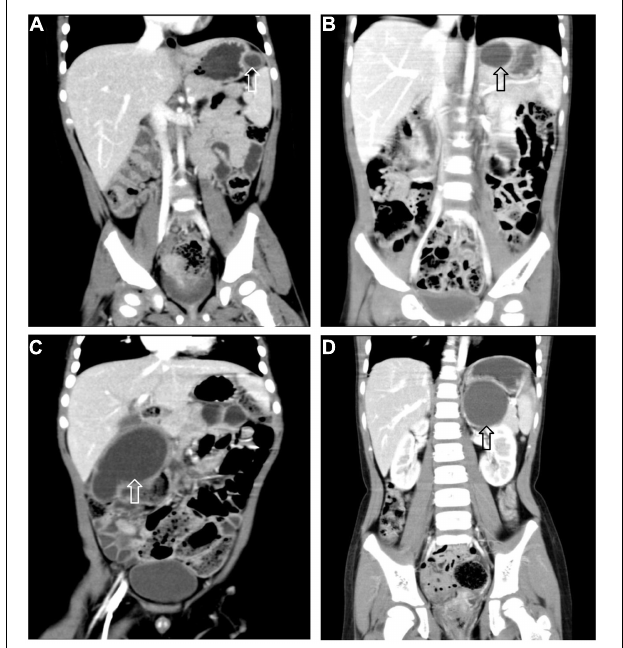
FIGURE 2 | Gastric duplication (arrow) located at different sites. (A) Greater curvature. (B) Cardia. (C) Pylorus. (D) Posterior wall of